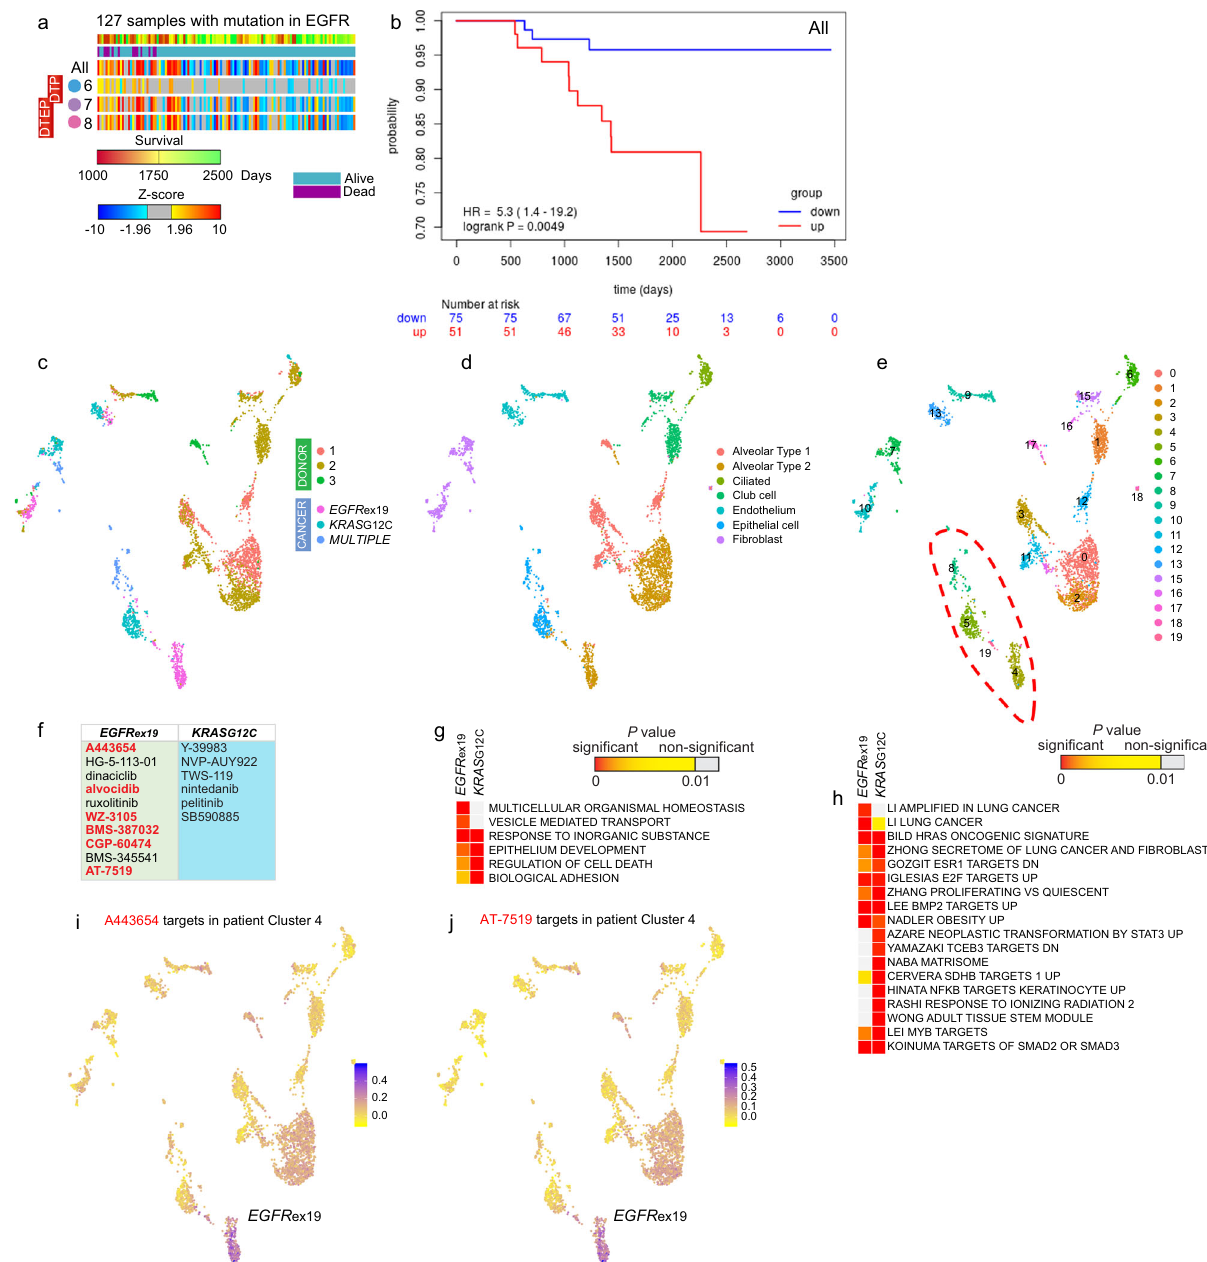
Fig. 8 scRNA-seq identi fi es cancer cell populations and potential drug sensitivity in patient tumors. a Sample-level enrichment analysis of DT markers, which were identi fi ed in the set of consecutive PC9 samples treated with erlotinib, in EGFR -mutant lung adenocarcinomas. Expression level was analyzed for markers of DT states in PC9 cells (Clusters 6, 7, and 8 in Fig. 1, and genes in Supplementary Data 1), for each individual DT state (6, 7, and 8) and for the three DT states altogether ( “ All ” ). b Kaplan – Meier estimates of survival before death/censored in 51 patients with signi fi cantly upregulated DT markers of three states (All) compared to 75 patients, where DT markers showed decreased expression or no signi fi cant change ( P > 0.05). Univariate Cox regression was used to determine Hazard Ratio (HR) and log rank P values. c – e UMAP representation of the epithelial subset of clusters in six tissues from different patients, colored by assigned cell types in d , and by cluster in e . Cancer cell clusters are indicated by red dotted line. f Top drugs identi fi ed in LINCS analysis as downregulating markers of EGFR ex19 and KRAS G12C patient tumors. Small molecules overlapping with top 10 LINCS drugs predicted for DT PC9 clusters are in red. g Enrichment analysis of EGFR ex19 cancer cluster markers ( n = 78) and KRAS G12C cancer cluster markers ( n = 102) for gene relations to GO BP terms. Terms with P < 10 − 6 were included. h Enrichment analysis of cancer cluster markers for CGP gene sets. Gene sets with P < 5 × 10 − 6 and >6 markers were included. In g and h , data represents right tail P values, two-sided binomial statistical test, adjusted for multiple testing using Benjamini-Hochberg FDR method. i , j Feature plots showing cells colored by expression level of genes targeted by the AKT inhibitor A443654 or CDK inhibitor AT-7519 identi fi ed in the LINCS analysis. The score was calculated by Seurat and was based on expression level of markers of EGFR ex19 patient cancer cells (Cluster 4 in e and genes from Supplementary Data